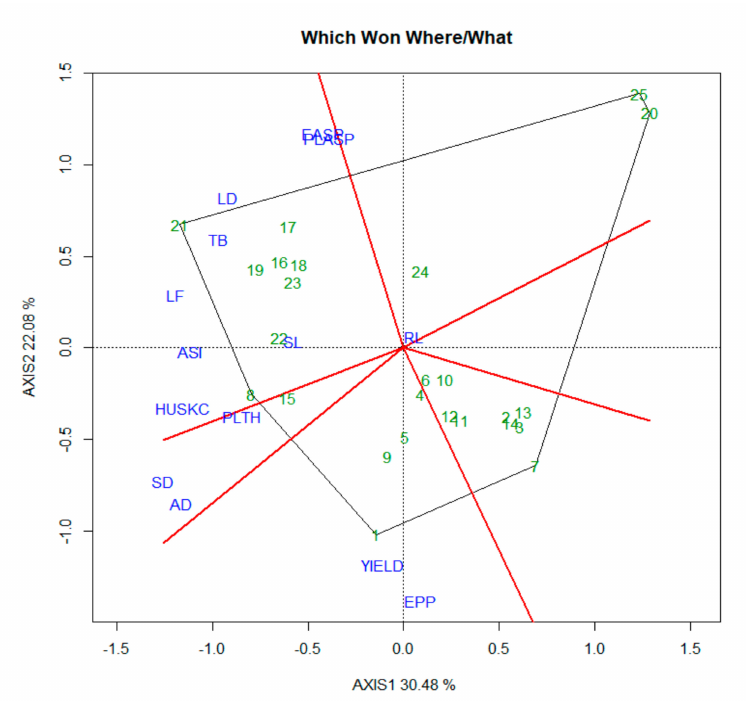
Figure 7. A “Which is best / worst for what” or “Which wins where” of GxT biplot of the 25 early maturing maize inbreds assessed under combined heat and drought conditions at Kadawa in Nigeria and Manga in Ghana during the dry seasons of 2018 and 2019. PC1 and PC2 for model 2 explained 52.56% of the variation among traits. YIELD = yield, EPP = ears per plant, RL = root lodging, SL = stalk lodging, SD = days to silking, AD = days to anthesis, ASI = anthesis silking interval, PLTH = plant height, LF = leaf firing, TB = tassel blast, LD = leaf death, HUSKC = husk cover, EASP = ear aspect, PLASP = plant